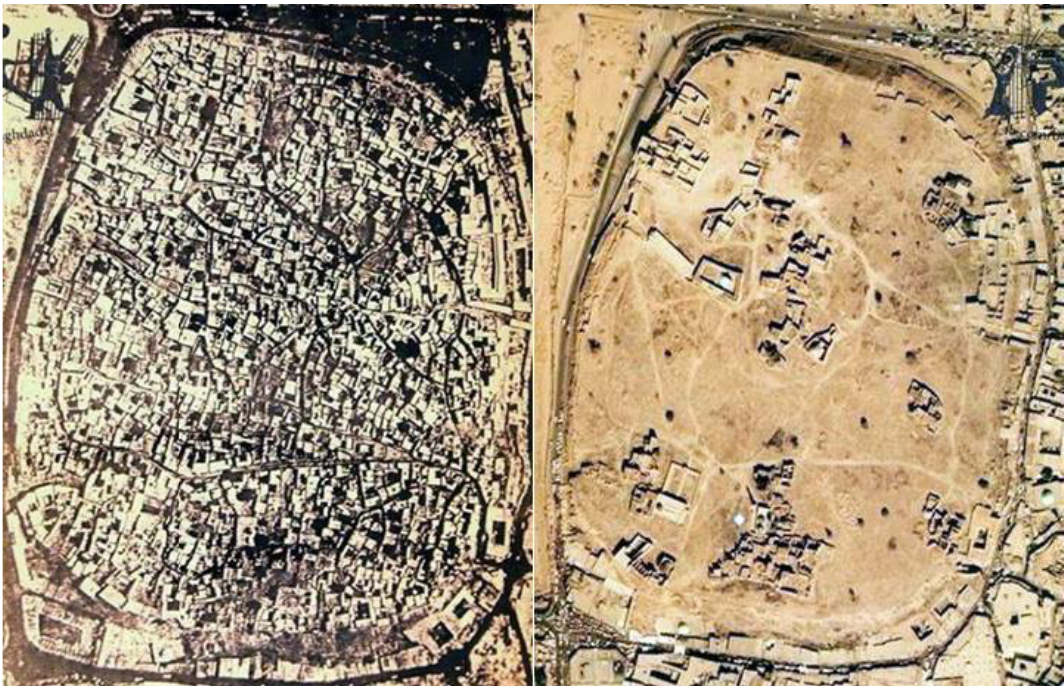
Figure 1 The current land use of Kirkuk Citadel, redrawn from the hand-drawn site plan of the Citadel by Kirkuk Directorate of Antiquities and Heritage (KDAH) (Mustafa Mokhtar’s archive)